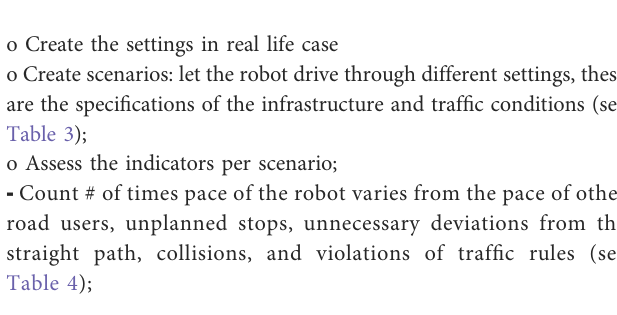
Explanation: Table 4 represents the number of observations for one run (driving the route in this case the basis scenario). In case of